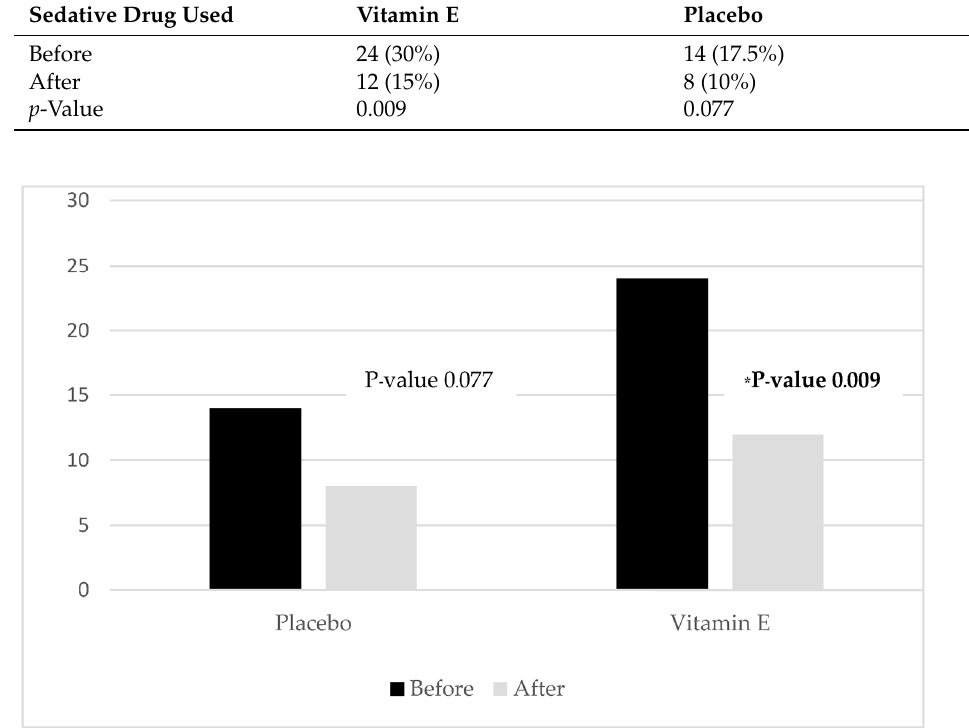
Figure 3. Histogram representing the reduction of sedative drug percentage used in each group. * statistical significance. * statistical